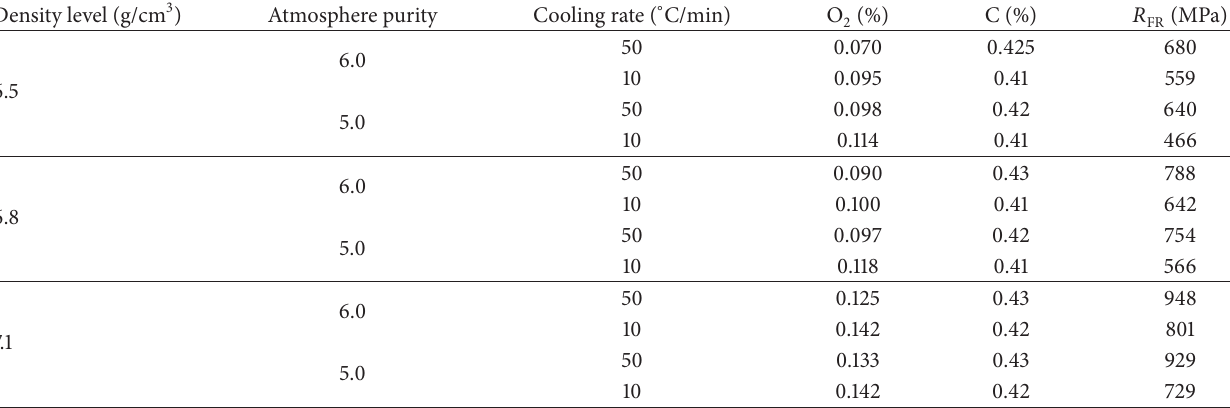
Table 6: Effect of atmosphere purity and cooling rate on oxygen and carbon contents in AstCrM + 0.5% C material sintered at 1120 ∘ C for 30 min in relation to